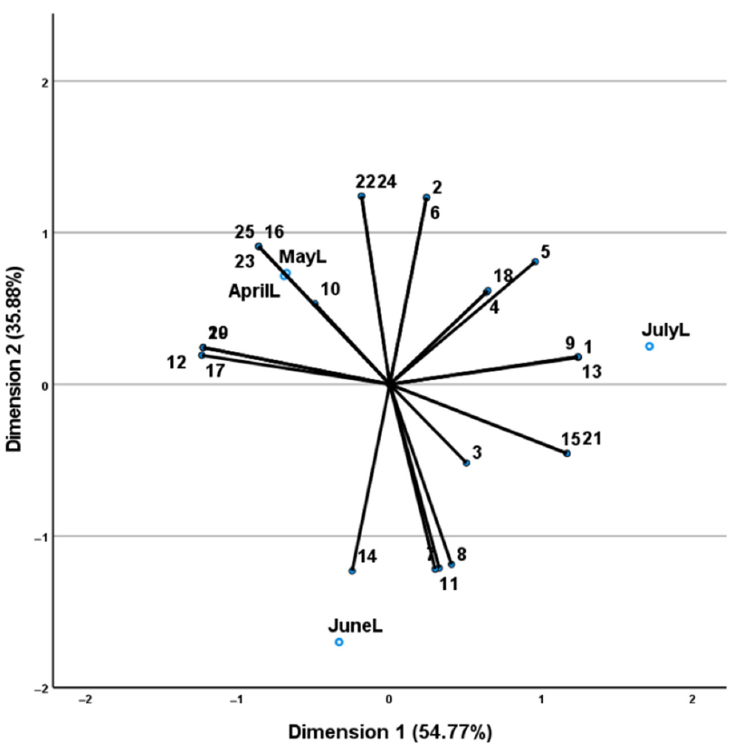
Figure 2. CATPCA analysis of the M. × piperita leaf tissue samples (coded as name of collection month followed by L for leaves) based on their essential oil compounds (numbers of which correspond to those of Table 1). Axes 1 and 2 accounted for 90.66% of the total variability and the total value of Cronbach’s alpha (alpha = 0.996) indicated a high level of internal consistency.